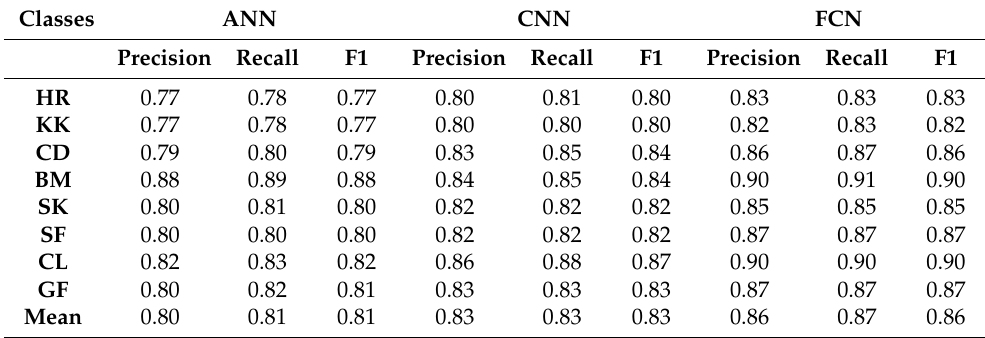
Table 8. Comparison with well-known classifiers in terms of precision, recall, and F1 measure over YouTube Aerial